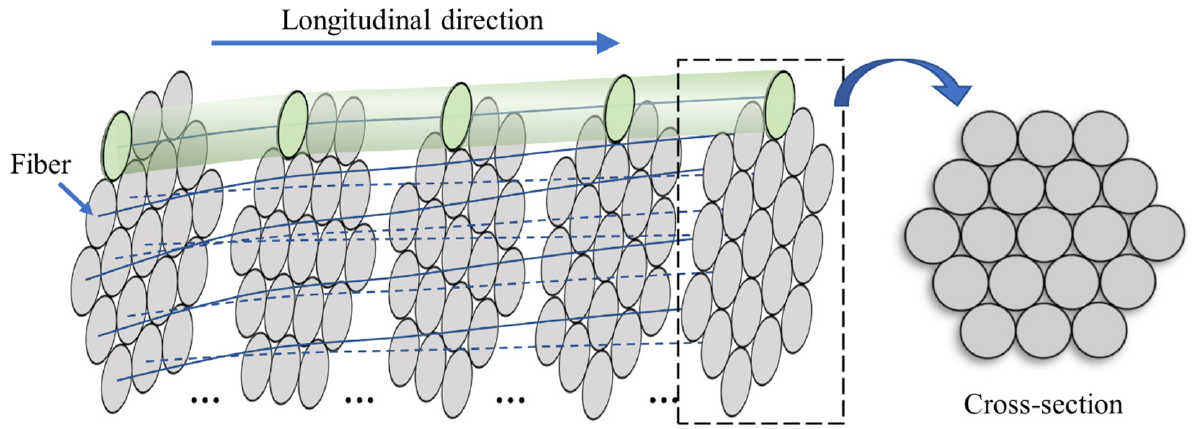
Figure 3. The 3D segmented clockwise twisted yarns. (Note: the gray is a cross-section of yarn, and the green is a cross-section of fiber).